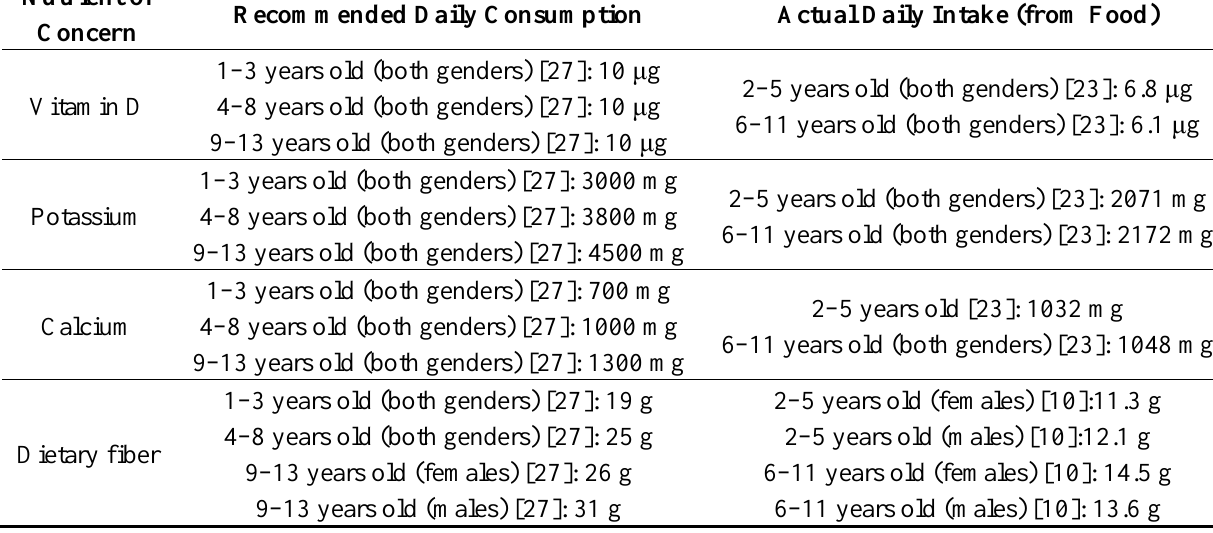
Table 2. 2010 DGA Nutrients of Concern: Recommended Intake versus Actual Consumption, Comparisons using Dietary Reference Intakes or Adequate Intake and 2009–2010 NHANES data for Children 2–11 Years